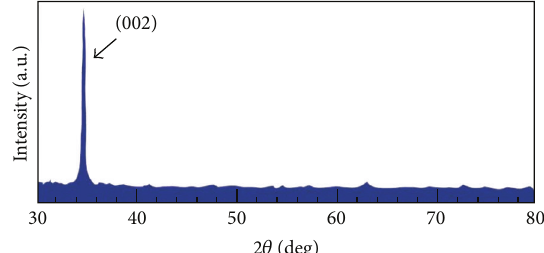
Figure 3: Representative XRD pattern of the ZnO:Zr:F thin solid films.